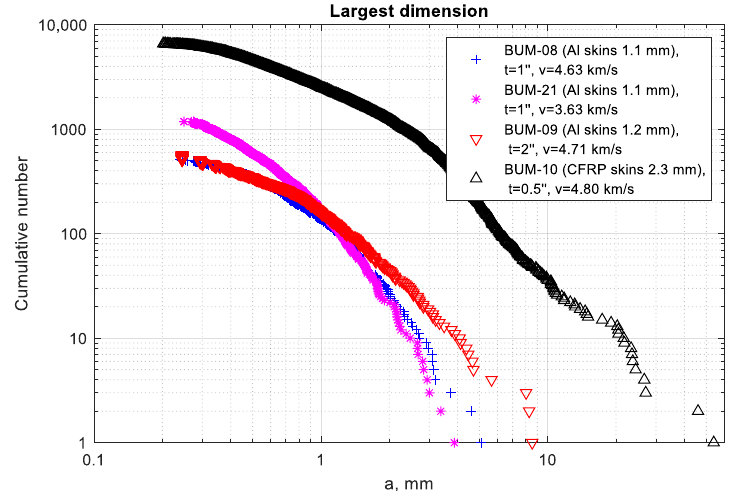
Figure 9. Fragment cumulative size distributions for the tests on sandwich panels [46].